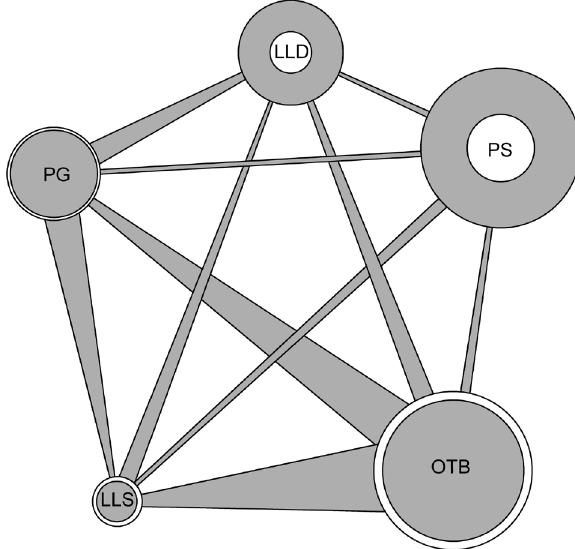
F ig . 2. – Sociogram of five fleets in Catalonia. The white circle is proportional to T (dominance) the grey one to the main diagonal (independence).